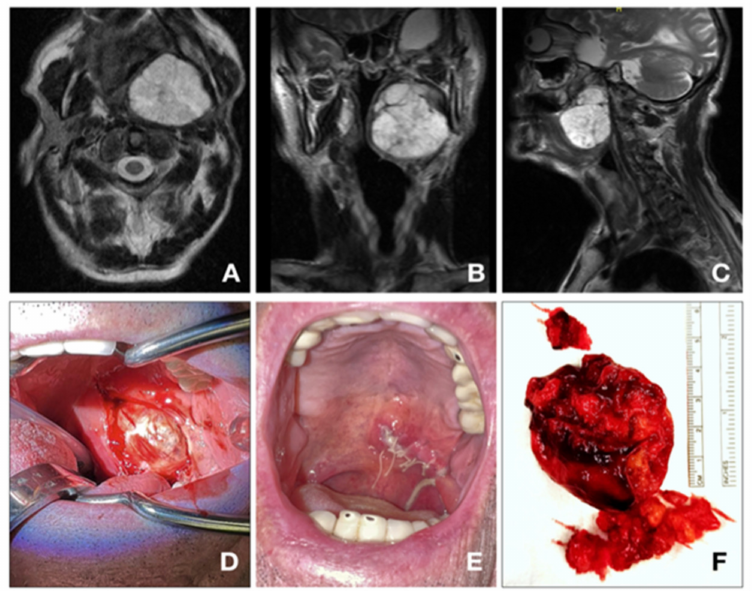
Figure 3. ( A ) 91 y.o. patient, treated for a pleomorphic adenoma of the deep parotid lobe (56 × 49 × 50 mm). ( A – C ): MRI t2-TSE ax; ( D – F ): Tumor excision/transoral